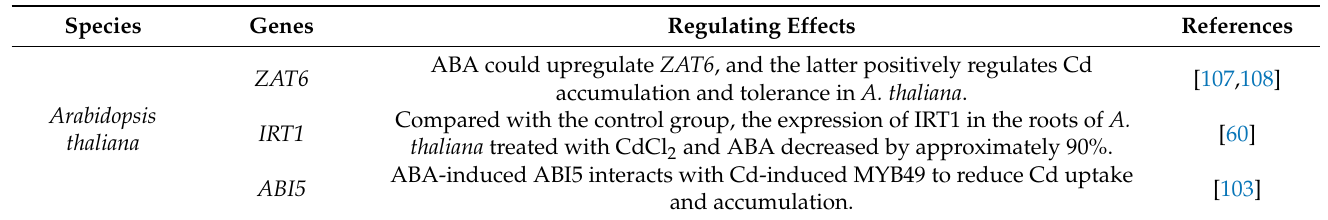
Table 1. Regulation of Cd-responsive genes in plants by